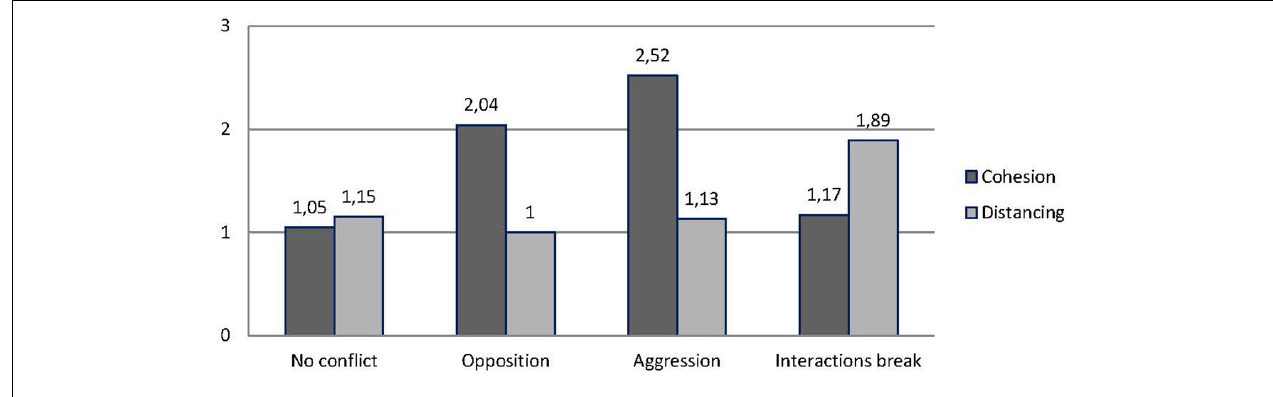
FIGURE 4 | Cohesion and distancing by conflict categories.